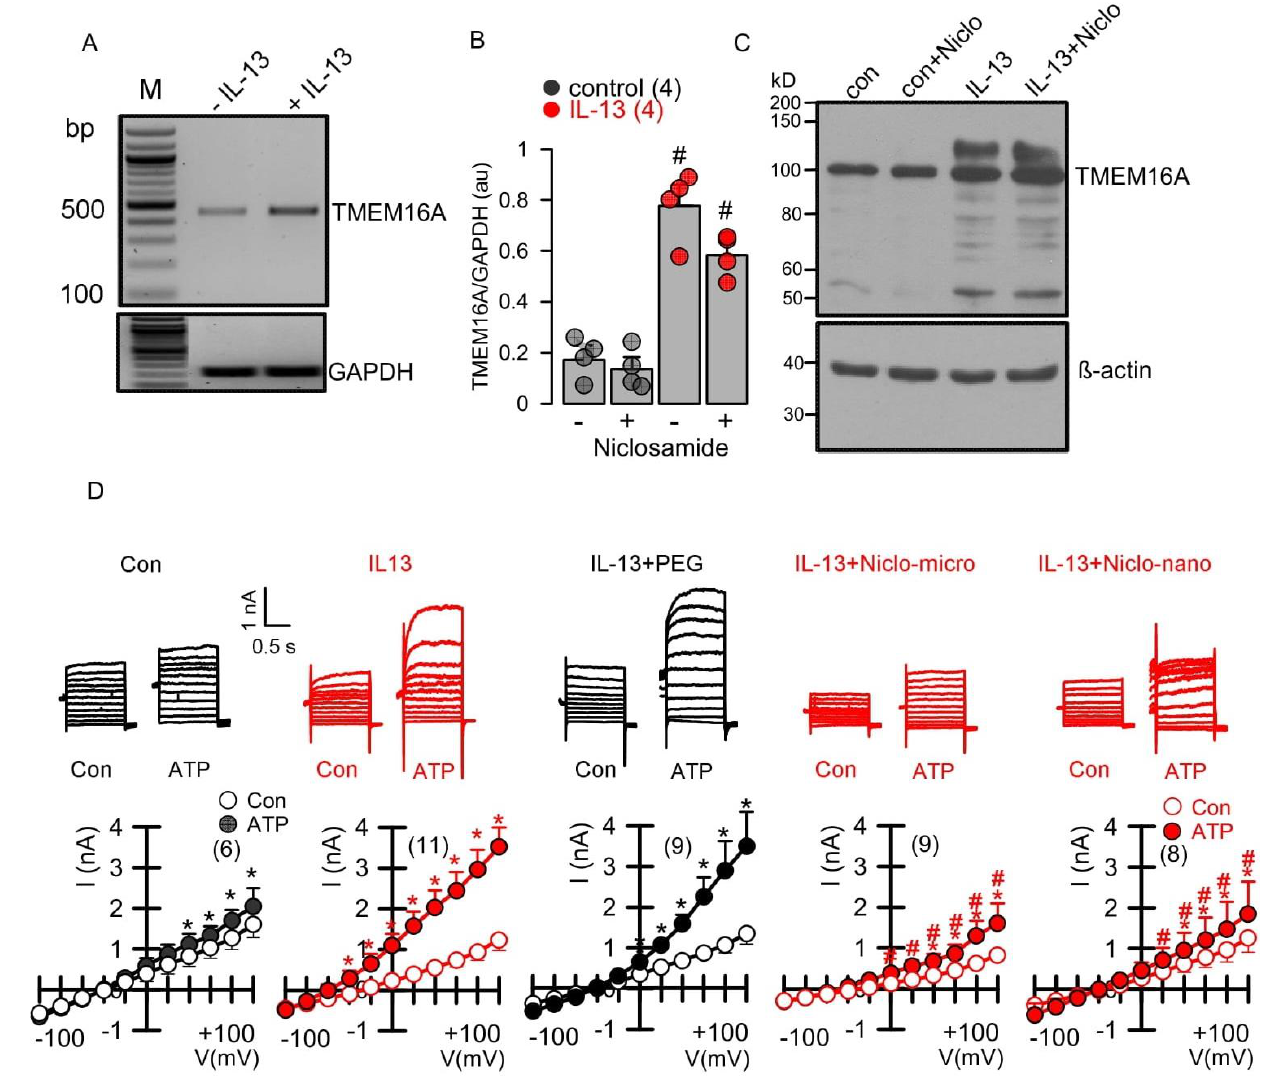
Figure 5. Enhanced expression of TMEM16A in Calu-3 human airway submucosal epithelial cells by IL-13 and inhibition of TMEM16A currents by Niclo-spheres. ( A , B ) RT-PCR analysis demonstrating enhanced expression of TMEM16A after incubation by IL-13 (20 ng/mL; 72 h) in the absence or presence of niclosamide (1 µ M) (number of reactions). ( C ) Western blot indicating upregulation of TMEM16A- expression by IL-13 in the absence or presence of niclosamide. Note that expression of the glycosylated form of TMEM16A (upper band) is enhanced upon exposure to IL-13. Western blots were performed in triplicates. ( D ) Whole-cell current overlays (upper panels) and corresponding current/voltage relationships (lower panels). Activation of whole cell currents by purinergic stimulation (ATP; 100 µ M) was enhanced by IL-13. Niclosamide encapsulated in microspheres (1 µ M) or nanospheres (1 µ M) strongly inhibited activation of TMEM16A currents by ATP. Empty spheres (PEG only) did not inhibit TMEM16A currents. The inhibitor of Ca 2+ -activated KCNN4 K + channels, TRAM-34 (100 nM), was present in all patch clamp experiments, to avoid potential activation of Ca 2+ activated K + channels. Mean ± SEM (number of cells). * significant activation by ATP ( p < 0.05; paired t -test). # significant difference when compared to the absence of microspheres or nanospheres ( p < 0.05; unpaired t -test).